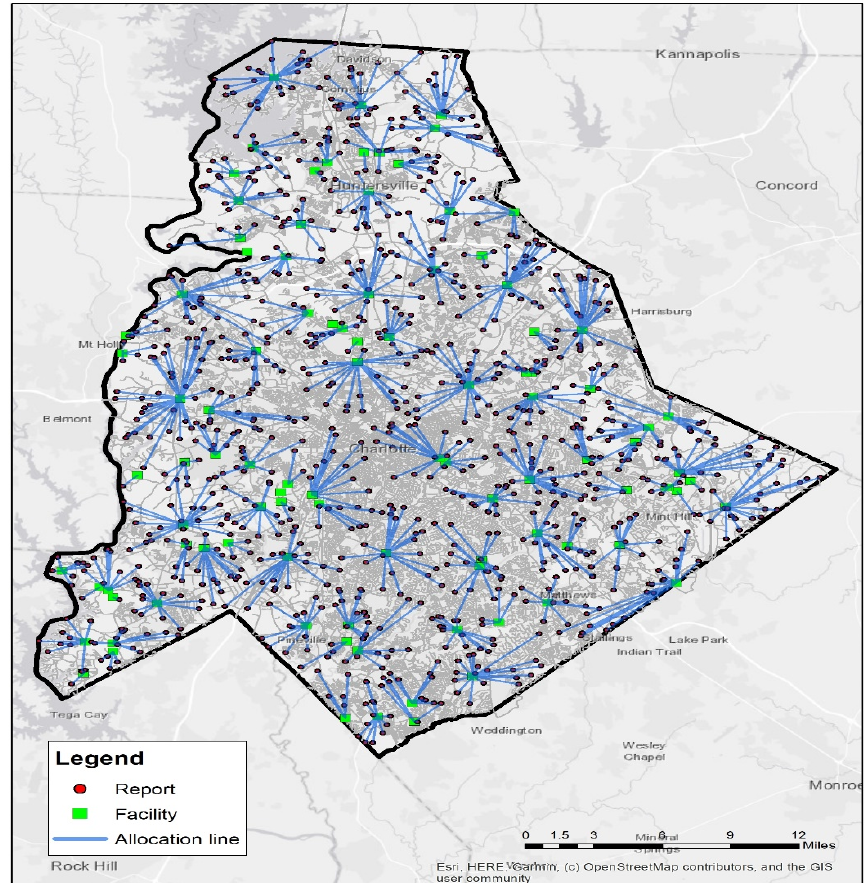
Figure 3. Facility Allocation.